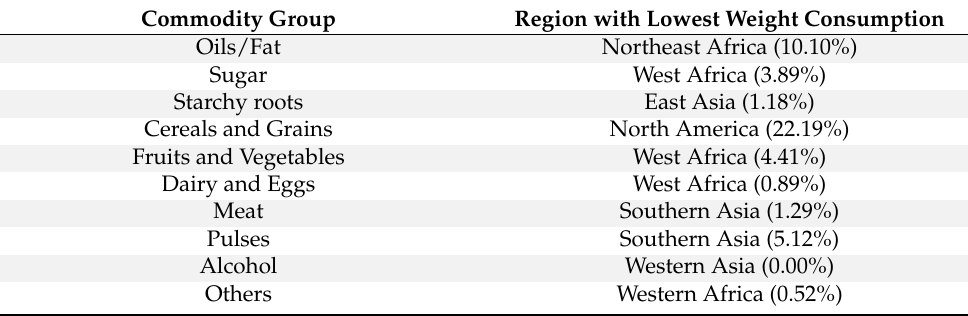
Table 3. Regions with the lowest weighted consumption of the 10 total commodity food